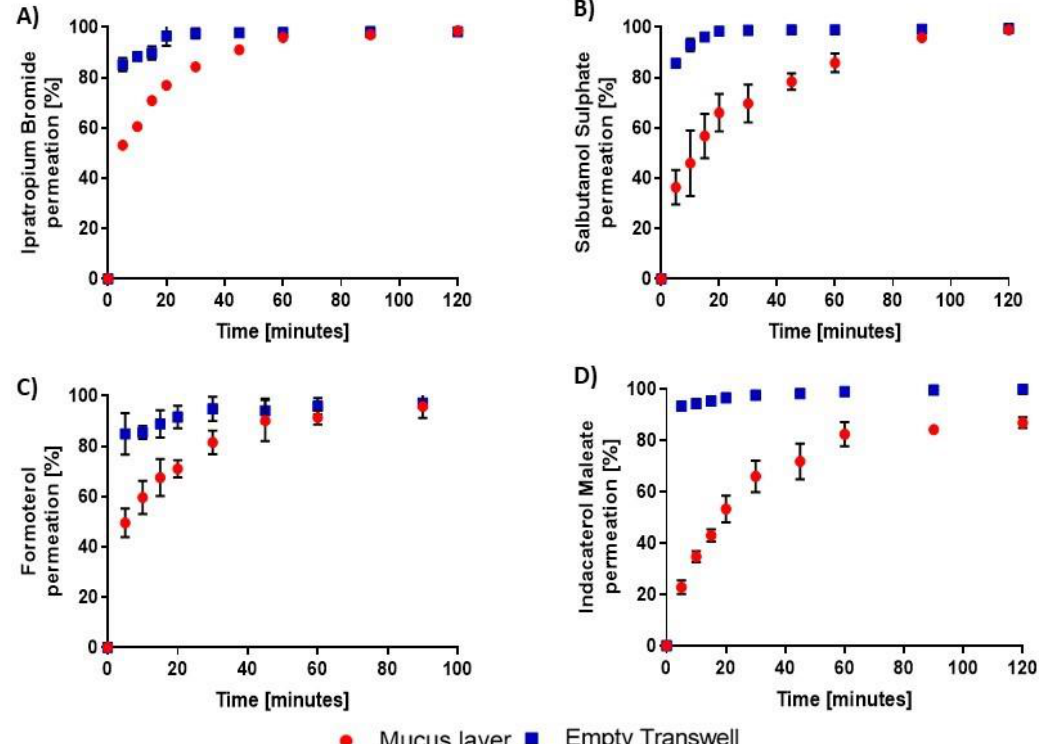
Figure 6. Permeation profiles of inhaled bronchodilators after they were sprayed at a distance of 20 cm onto mucus layers mounted onto 3.0 µm pore size polyester Transwell ® inserts or corresponding empty inserts geometrically arranged to cover a 50 cm 2 surface area. A : ipratropium bromide; B : salbutamol sulphate; C : formoterol; D : indacaterol maleate. Data are expressed as cumulative percentage of the deposited dose recovered in the basolateral compartment as a function of time. They are presented as mean ± SEM (N = 4, n = 4).